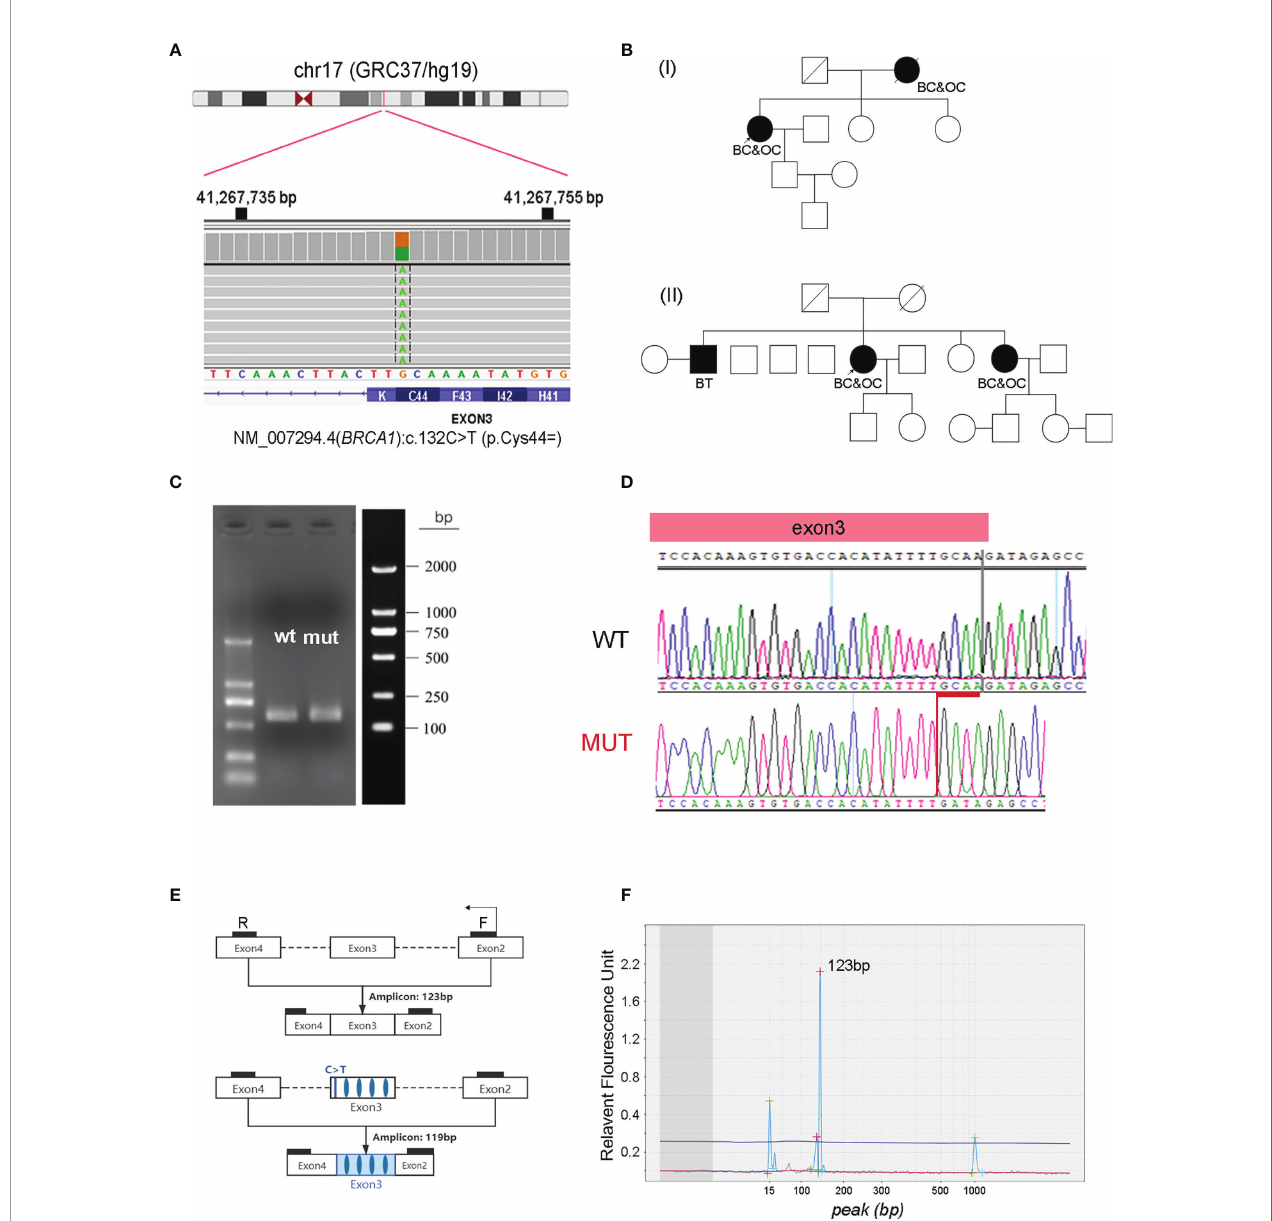
FIGURE 1 | Characterization of NM_007294.4 ( BRCA1 ):c.132C>T (p.Cys44=) as a pathogenic variant. (A) Identi fi cation of the heterozygous BRCA1 :c.132C>T variant in one of the patients. The screen shot of this variant in the Integrative Genomics Viewer is presented. (B) Pedigrees of two unrelated patients carrying the synonymous BRCA1 :c.132C>T variant. (C) PCR amplicons generated from wild-type (wt) and BRCA1 :c.132C>T mutant (mut) constructs by a minigene assay, followed by agarose gel electrophoresis and band analysis. (D) Sanger sequencing determination of the deletion of GCAA (red) at the end of exon three in BRCA1 : c.132C>T mutant cells. (E) Designed primers fl anking exon three for RT-PCR ampli fi cation. (F) Fragment analysis of the RT-PCR product using RNA isolated from the blood cells of patients with BRCA1 :c.132C>T variant. The amplicon size is evaluated by using the high-resolution automated electrophoresis on an Agilent 2100 Bioanalyzer. BC, breast cancer; OC, ovarian cancer; BT, brain